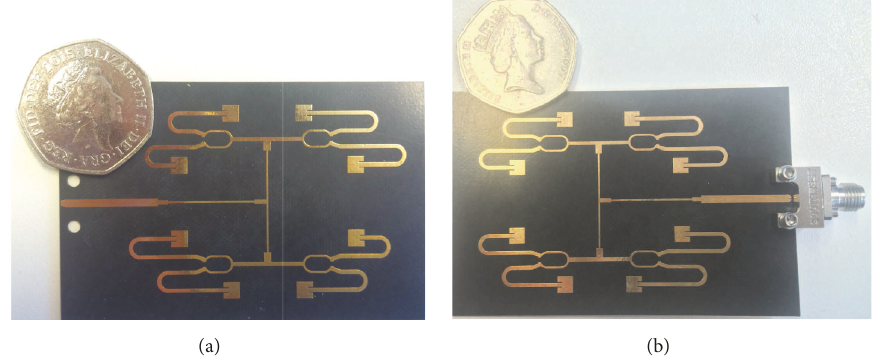
Figure 9: The fabricated antenna (a) without connector and (b) with connector.